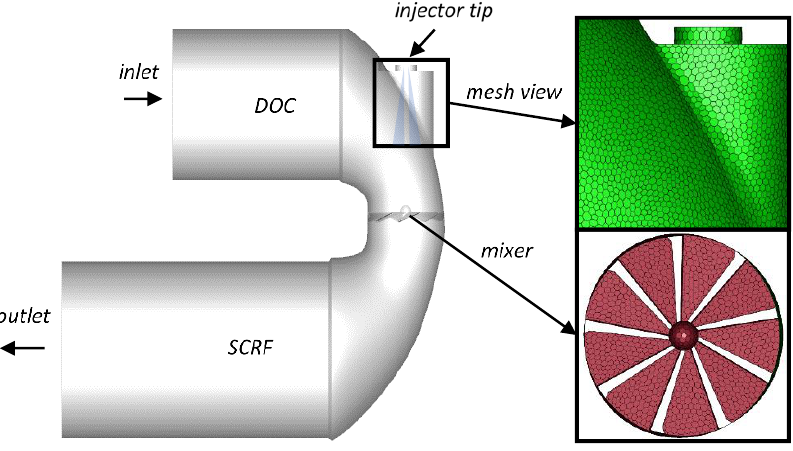
Figure 17. Urea–selective catalytic reduction (SCR) model with zoom in on the mesh and the mixer.